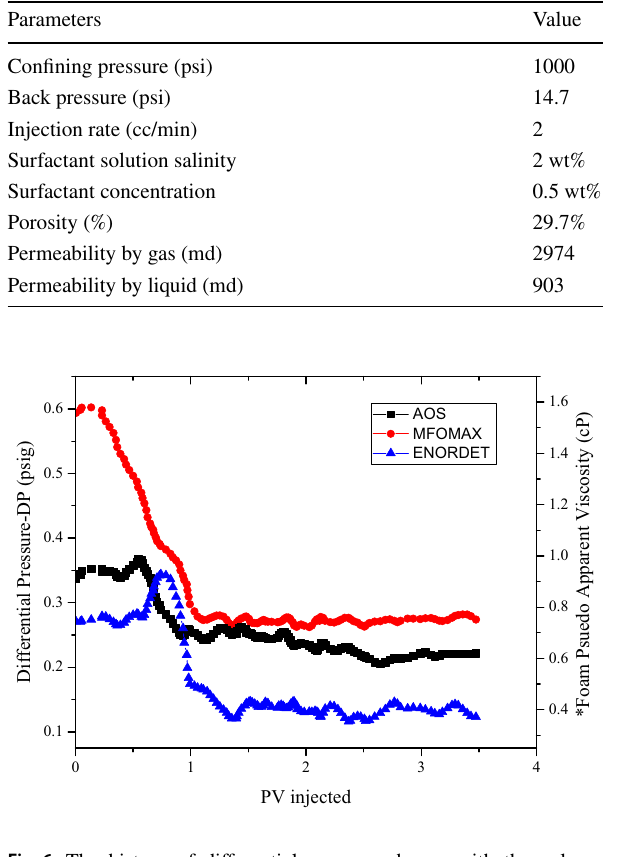
Fig. 6 The history of differential pressure change with the volume of gas injected into the core initially saturated with surfactant solu- tion. The * indicates ( µ foam / K rg ) which is expected to be very close or slighter higher than the apparent